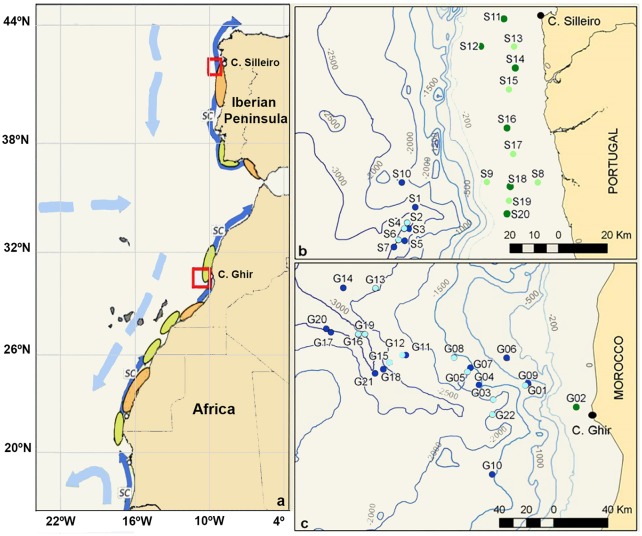
(a) Schematic map of the Iberian Canary Current eastern boundary upwelling showing the areas sampled (red boxes) and the main currents (light blue: surface currents; dark blue: slope current = SC), retention (orange), and dispersion (green) zones on the shelf. (b) Zooplankton samples collected off the coast of the NW Iberian Peninsula. (c) Zooplankton samples collected off the Morocco coast. Samples collected over the continental shelf (green, <200 m depth) and in the open ocean (blue, >200 m depth), with light/dark colors representing day/night samplings.